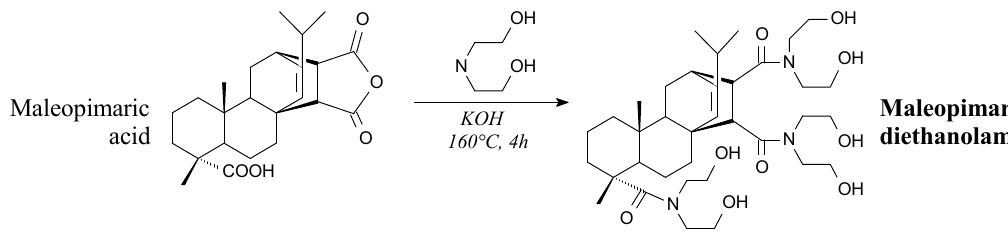
Scheme 35. Synthesis of maleopimaric acid diethanolamide.